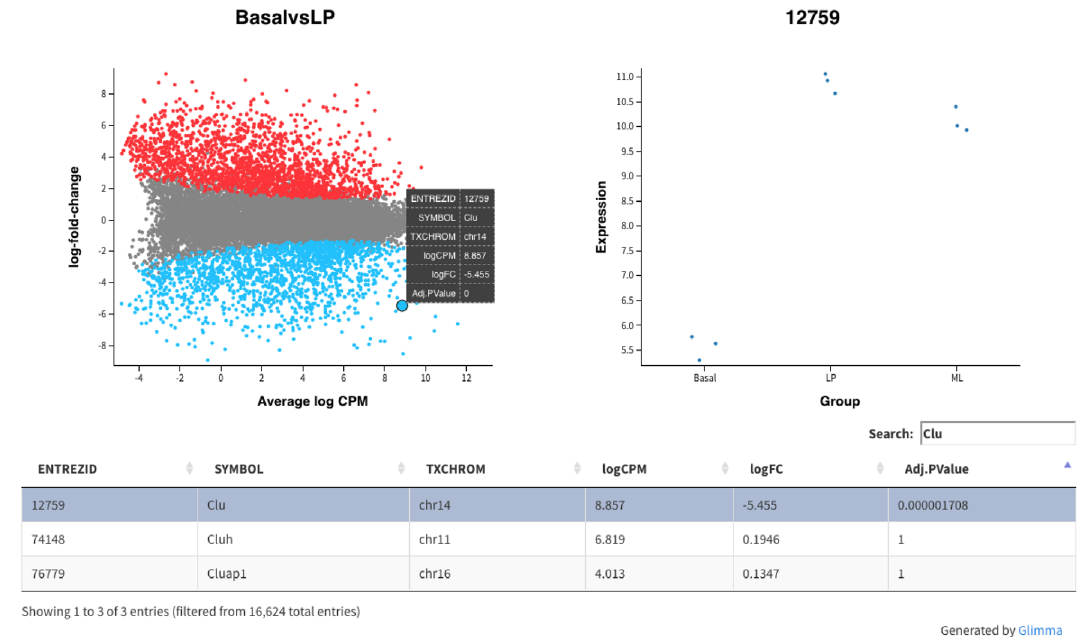
Figure 6. Interactive mean-difference plot generated using Glimma. Summary data (log-FCs versus log-CPM values) are shown in the left panel which is linked to the individual values per sample for a selected gene in the right panel. A table of results is also displayed below these figures, along with a search bar to allow users to look up a particular gene using the annotation information available, e.g. the Gene symbol identifier Clu